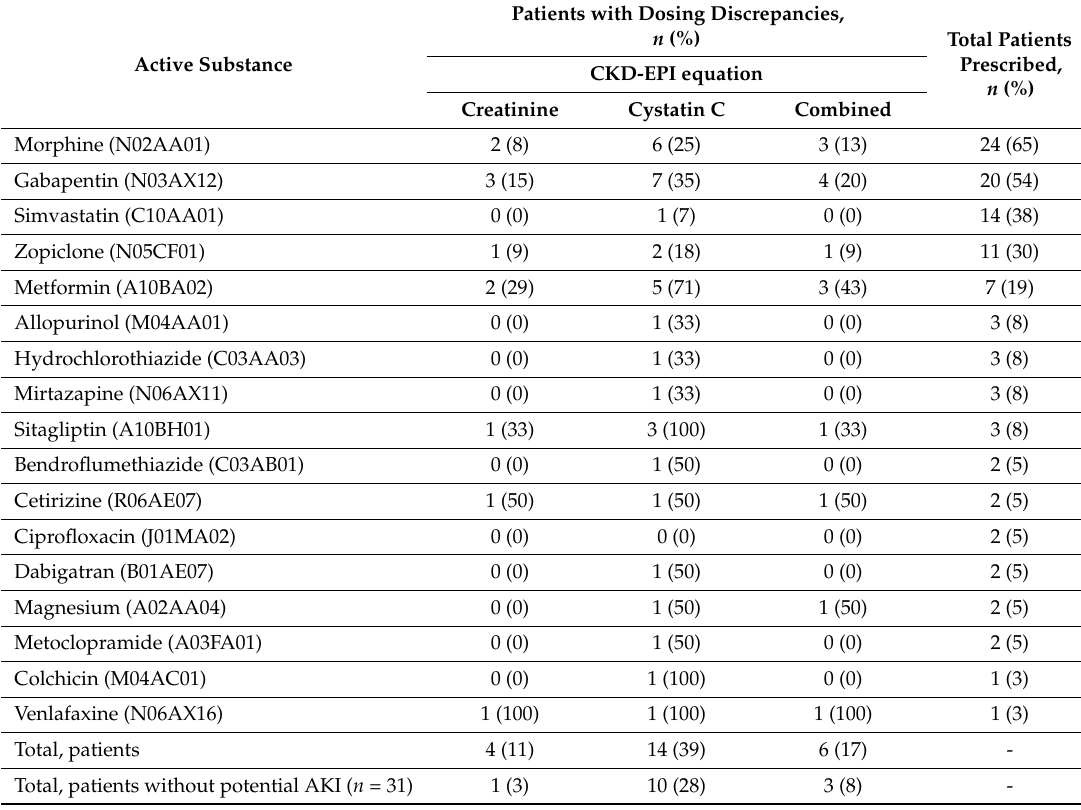
Table 4. Number of patients with dosing discrepancies during hospitalization according to eGFR on day 3 post-operation using CKD-EPI